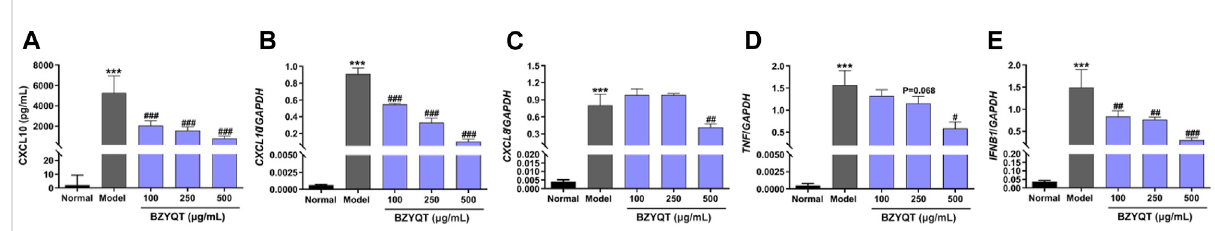
FIGURE 4 Effect ofBZYQTontheprotein content and mRNAexpressions ofin fl ammatorychemokinesand cytokines challenged bypoly (I:C) inBEAS-2B cells.Theproteincontentof (A) CXCL10inthecellsupernatants;mRNAexpressionof (B) CXCL10 , (C) CXCL8 , (D) TNF ,and (E) IFNB1 inthelung.Data were shown as mean ± SD ( n = 3) and analyzed by one-way ANOVA; differences identi fi ed using Dunnett ’ s multiple comparisons test: *** p